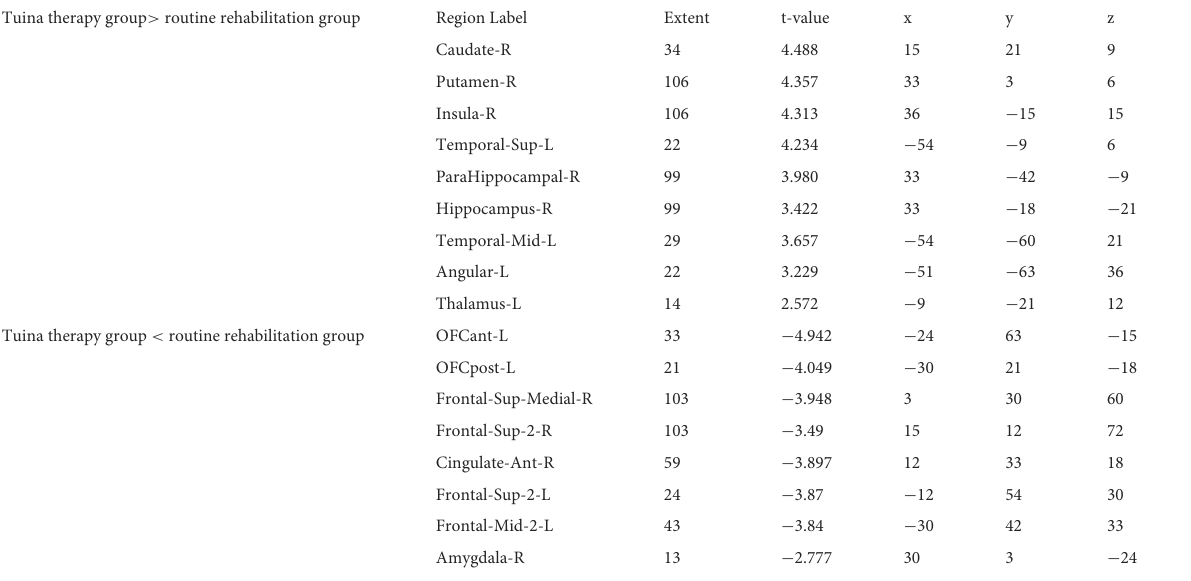
TABLE 3 Comparison of the post-intervention zALFF values of the two groups.